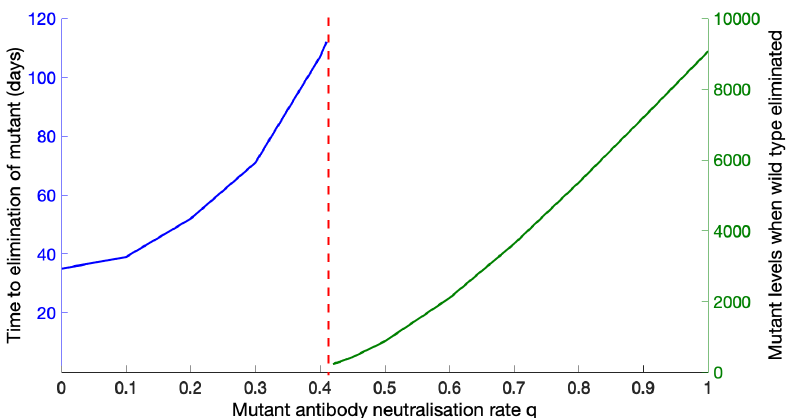
Figure 7. Sensitivity of the outcome to the mutant antibody-neutralisation rate, q . Below q = 0.41, elimination of the mutant is possible; above q = 0.41, elimination is no longer possible, and the mutant levels increase as q